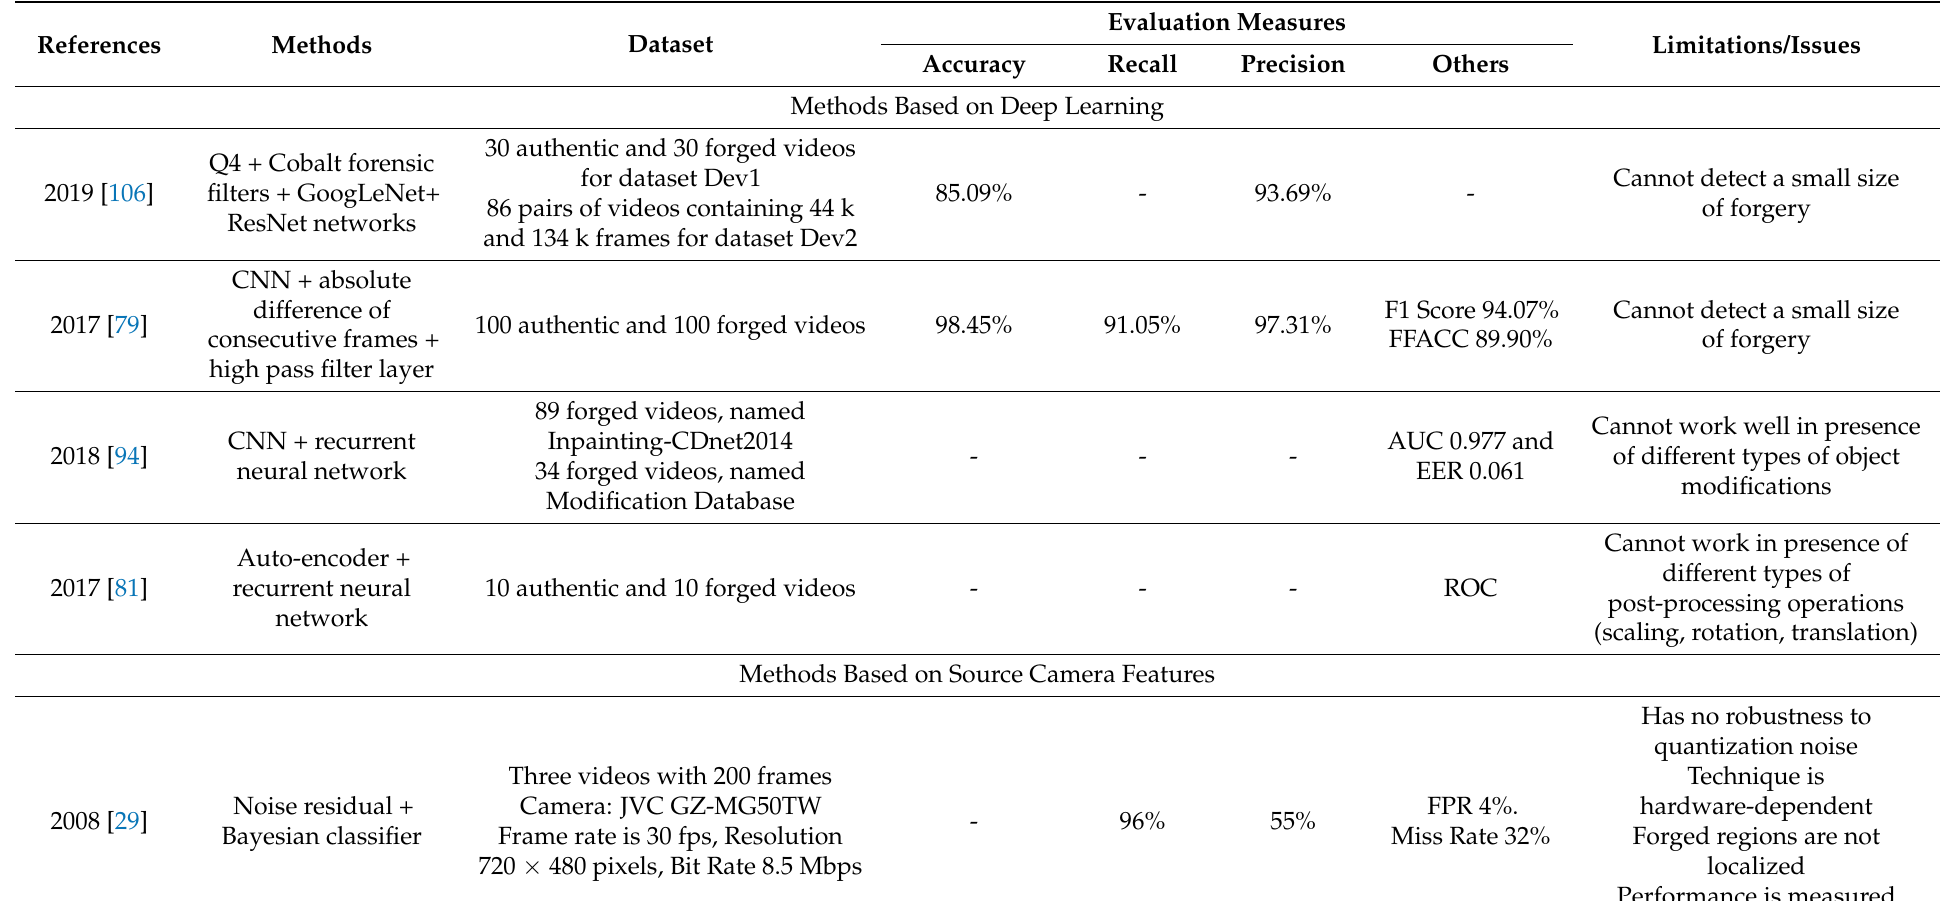
Table 3. Summary of spatial tampering (forgery) detection